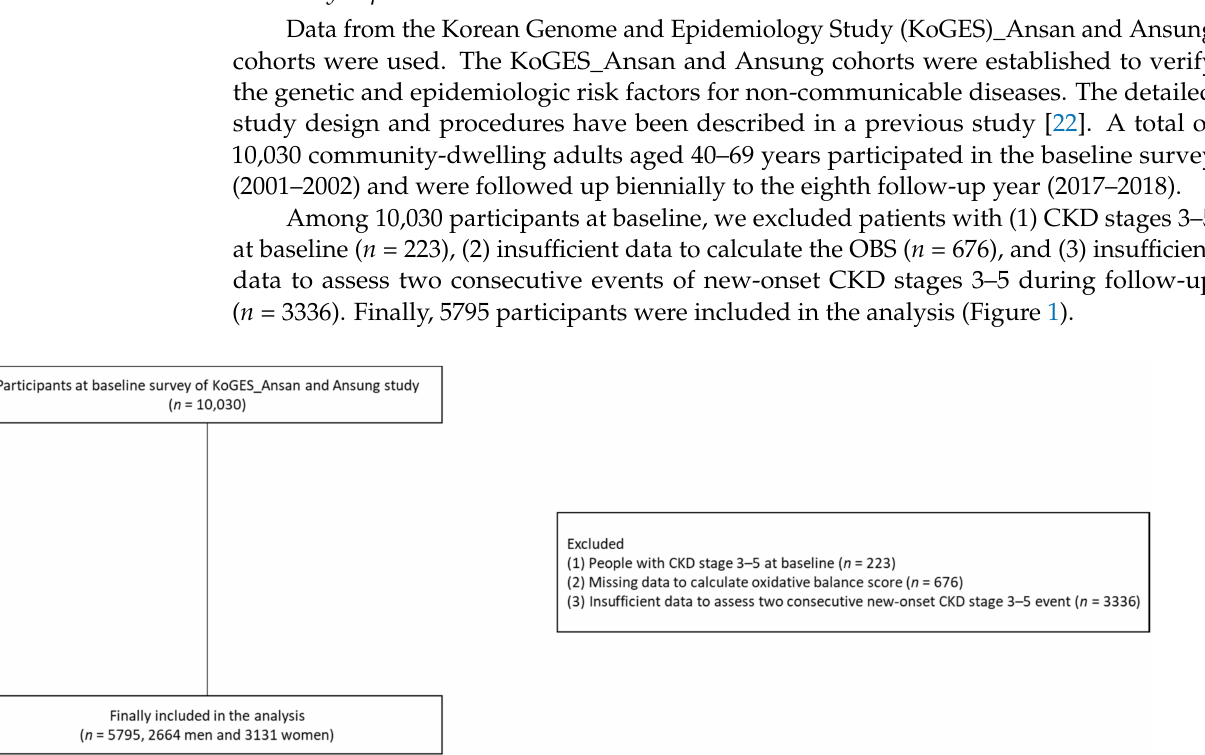
Figure 1. Flowchart of the study population. Abbreviations: KoGES, Korean Genome and Epidemiol- ogy Study; CKD, chronic kidney